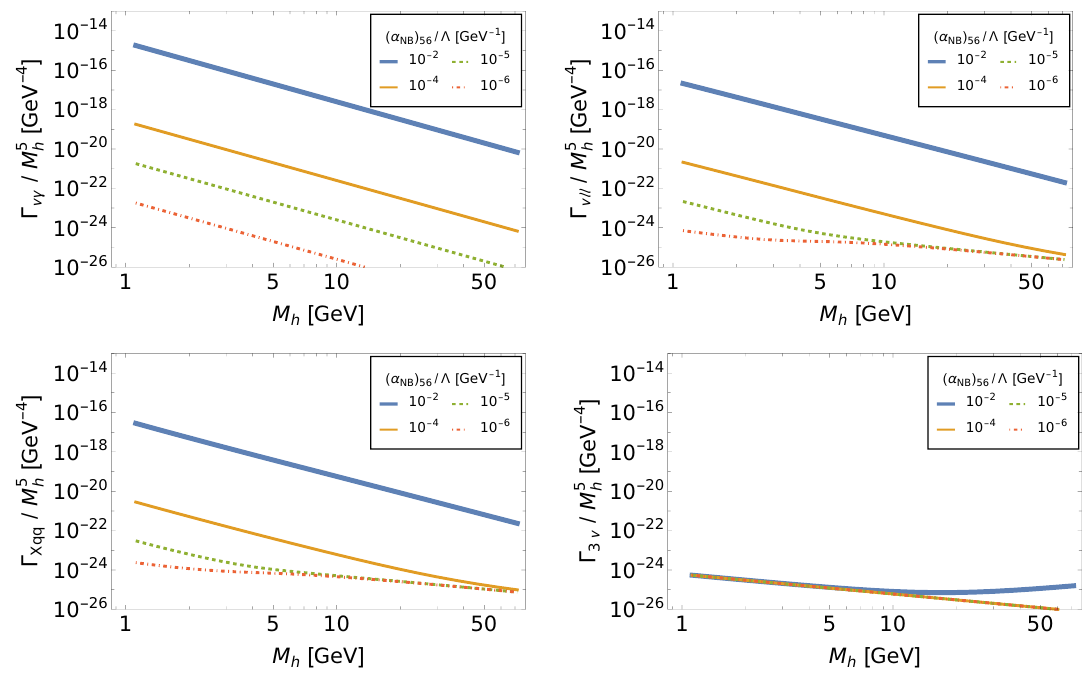
Figure 1 . Heavy neutrino partial width into several types of final state when including effective operators, normalized with respect to M 5 . From left to right, top to bottom, we show the partial h widths for N h → ν γ , N h → ν l l a , N h → X q q 0 and N h → 3 ν . On each panel we plot the widths a ( 0 ) for ( α NB ) 56 / Λ = 10 − 2 , 10 − 4 , 10 − 5 , 10 − 6 GeV − 1 in blue (thick), orange (thin), green (dashed), and red (dot-dashed), respectively. We take minimal